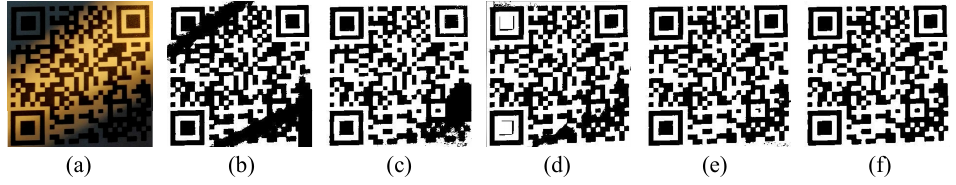
Figure 14. The original image and experimental results of different algorithms: ( a ) Original image; ( b ) Sauvola’s algorithm [6]; ( c ) Yao’s algorithm [18]; ( d ) Di’s algorithm [8]; ( e ) Chen’s algorithm [13]; ( f ) Proposed method.